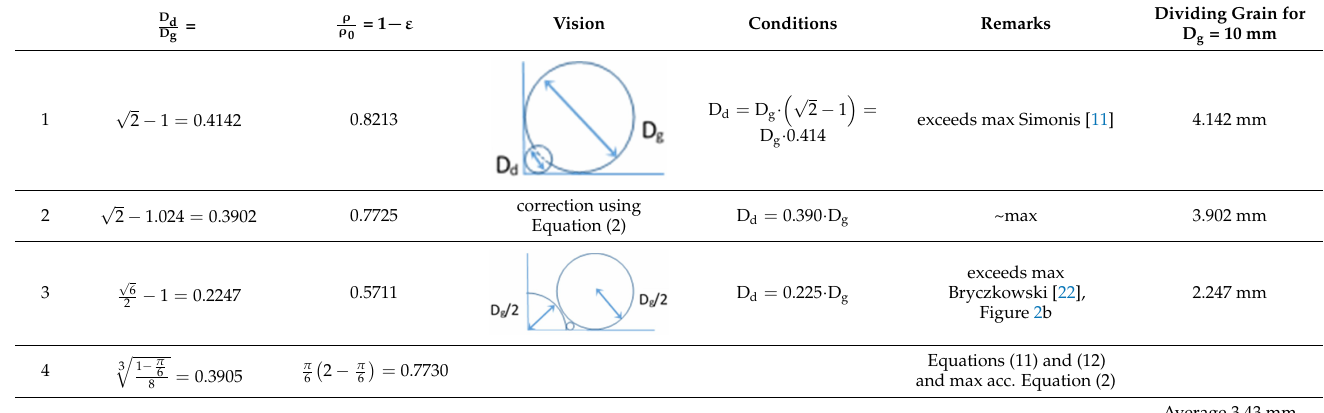
Table 2. Diameter for two fractions, coarse (g) and fine (d) grains.